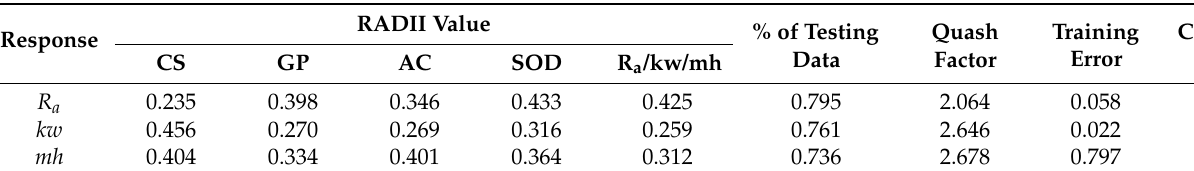
Table 5. ANFIS optimal parameters obtained through GA.